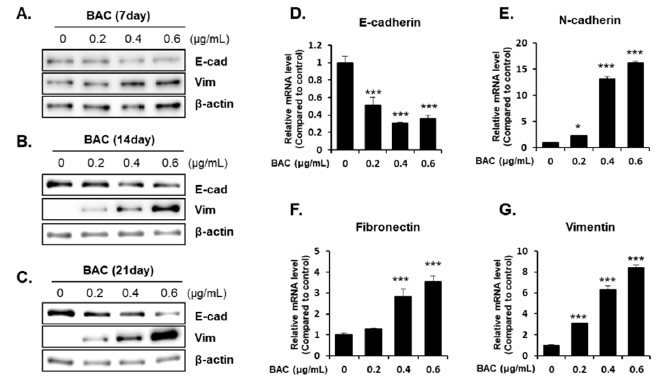
Figure 5. BAC-indcued epithelial–mesenchymal transition (EMT) in H358 cells . ( A )–( C ) Changes in protein levels of E-cadherin and vimentin in H358 cells exposed to BAC for 7, 14, and 21 days. β -actin is used as a loading control. mRNA levels of ( D ) E-cadherin, ( E ) N-cadherin, ( F ) fibronectin, and ( G